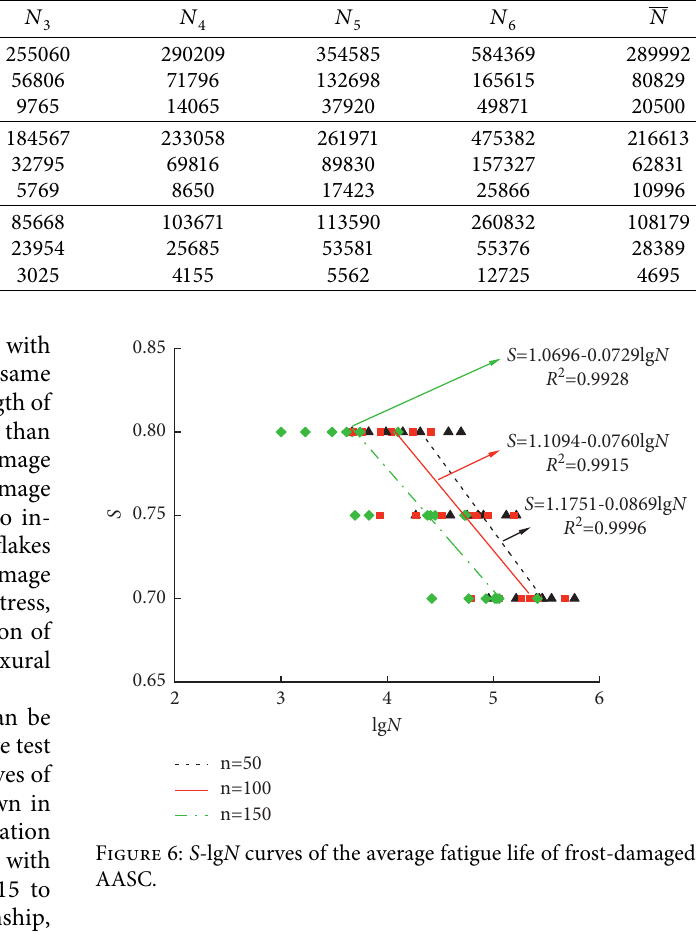
Table 5: Flexural fatigue lives of frost-damaged AASC samples.